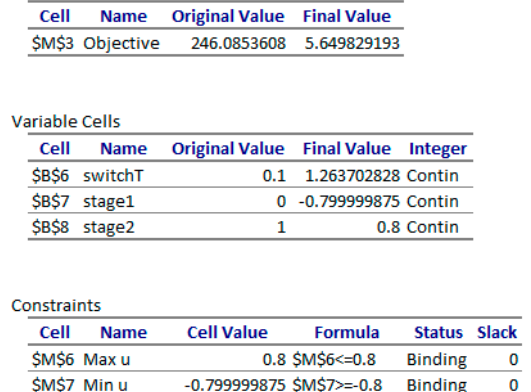
Figure 6. Answer Report generated by Excel’s Solver for optimal control problem (6)–(10).